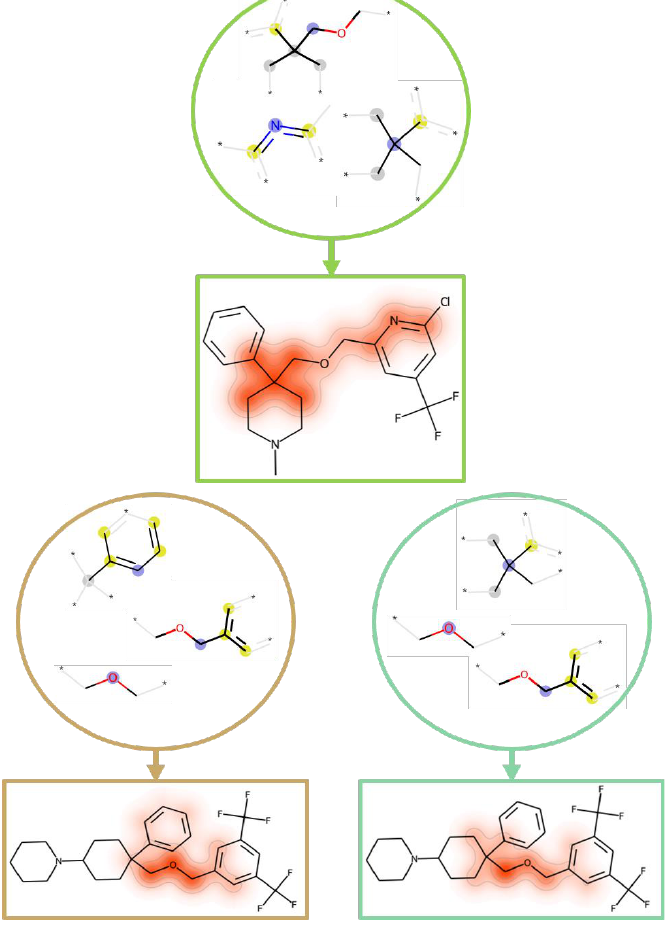
Figure 5. Most important features. At the top, the three most important features for correct predictions with the MT model are shown for the same set of MT-CPDs as in Figure 4. The features were mapped onto a compound with the largest cumulative SHAP values for them. Shown below are the top three features for the prediction of ST-CPDs (lower left) or MT-CPDs (lower right) using the ST model. These features were mapped onto another MT-CPD that contained them. The color code and representation are according to Figure 4. The different predictions shared one or two individual top-ranked features.